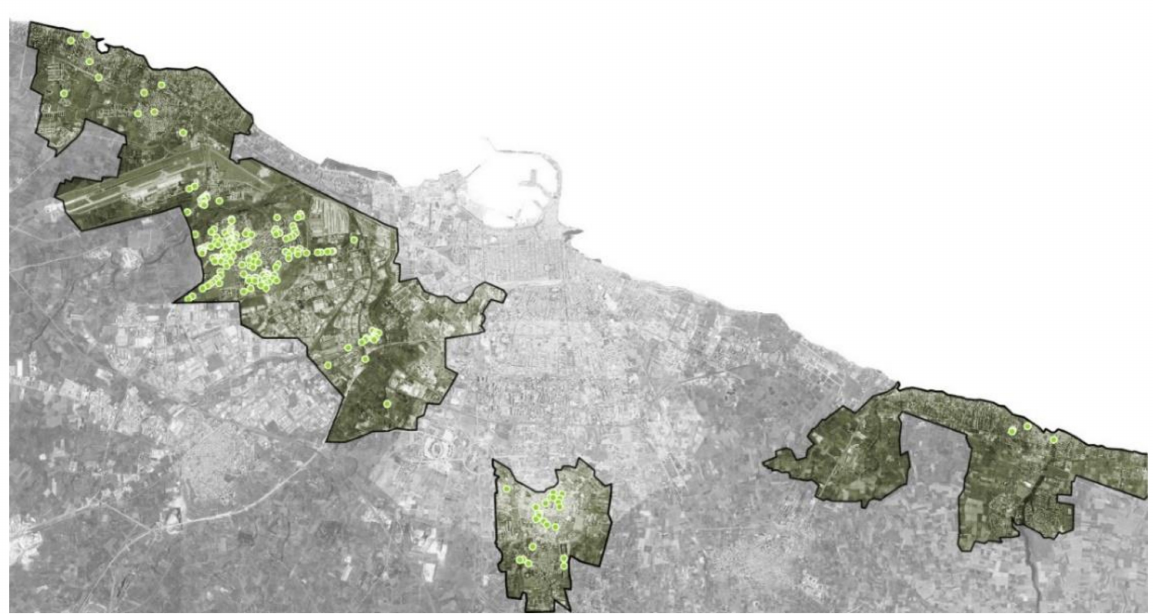
Figure 4. Localization of the study sample properties in the OMI suburban area of the city of